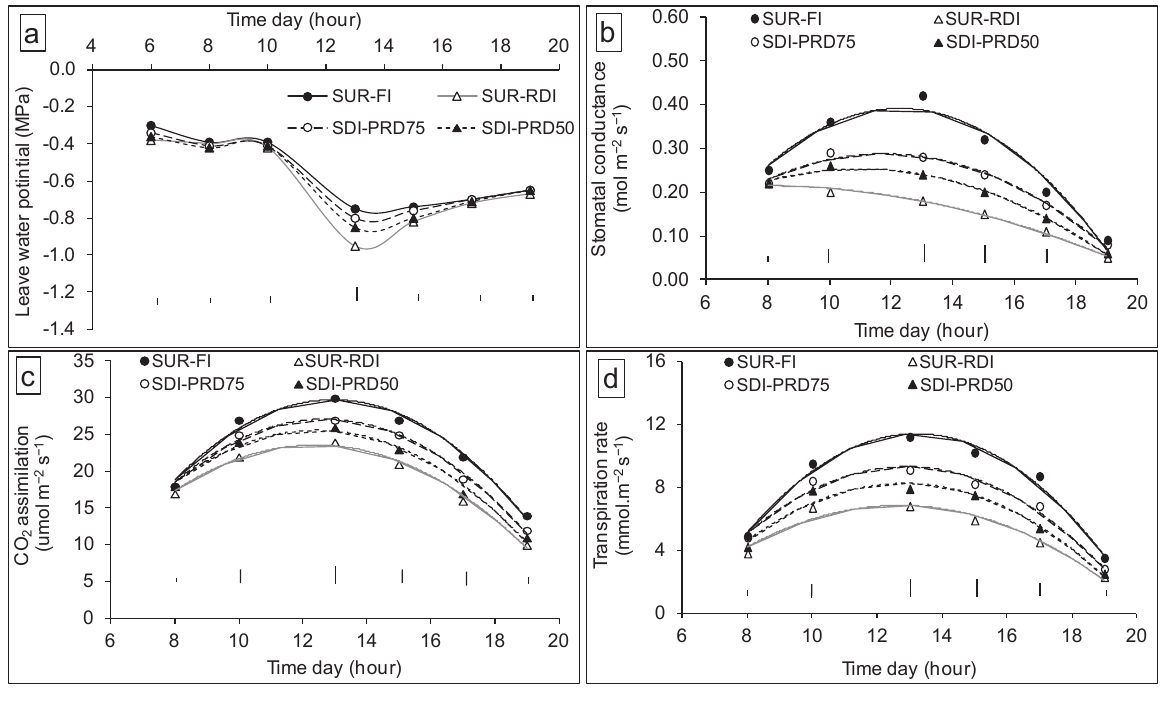
Fig. 3: Diurnal changes of leaf water potential (a), stomatal conductance (b), CO 2 assimilation rate (c) and transpiration rate (d) of tomato grown under different drip irrigation treatments at flowering stage. Data points are two years pooled data of three replications. Least significant differences (LSDs) at P ≤ 0.05 are presented as vertical line bars. FI = full irrigation; PRD = partial root zone drying; RDI = regulate deficit irrigation; SDI = subsurface drip irrigation; SUR = surface drip irrigation. Tab. 2: Tomato fruit yield, shoot dry weight (DW), total dry weight, harvest index (HI) and water use efficiency (WUE) as affected by different drip irrigation treatments.